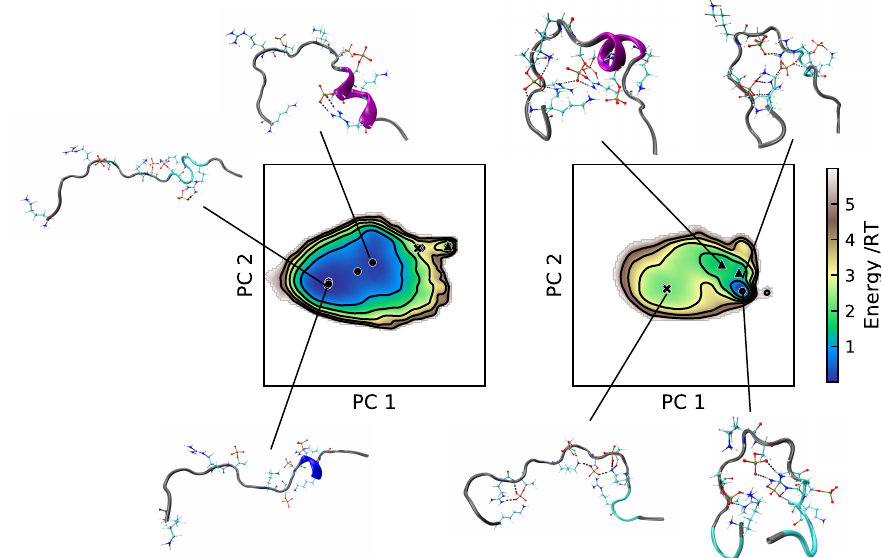
Figure 6. Energy landscapes and conformations in selected minima of Tau2. ( Left ) A99; ( right ) C36. The energy landscapes are constructed using the first two components from principal component analysis, using the same basis set for both force fields, such that they are directly comparable. Contour lines are drawn for integer energy levels in the interval 1 ≤ RT ≤ 5, and the minimum of each basin is represented by a marker: (cid:108) : energy ≤ 1 RT , (cid:115) : ≤ 2RT, (cid:54) : ≤ 3RT. In the conformations, the phosphorylated and positively charged residues are shown explicitly. Dashed black lines represent hydrogen bonds. The peptide conformations are color-coded according to the secondary structure determination in VMD, where silver is irregular (coil), cyan is turns, magenta is the α -helix, and blue is the 3 10 -helix. The N-terminus of each conformation is the leftmost end.